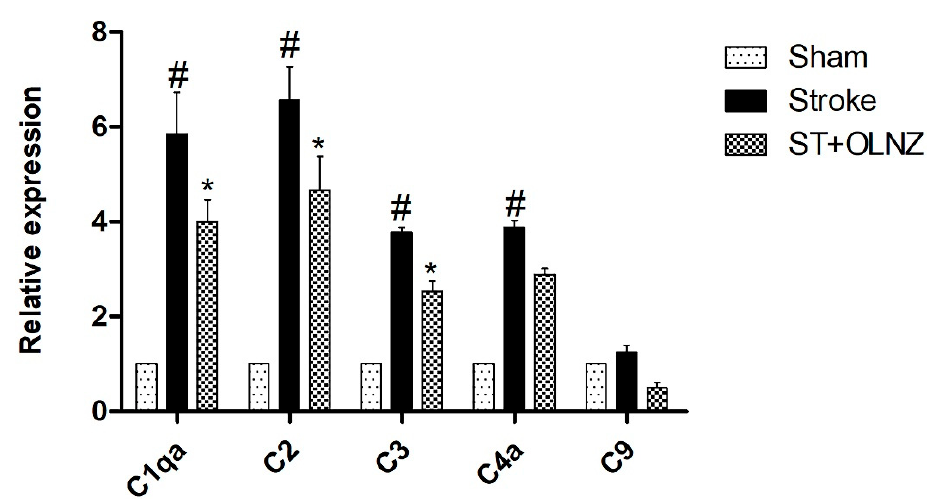
Figure 9. Protective role of OLNZ on gene expression of complement components in the hippocampus during transient-ischemia (TI)-induced stroke in gerbils. In TI-induced stroke, gene expression of C1q, C2, C3, C4a, and C9, was significantly upregulated, whereas treatment with OLNZ markedly downregulated the expression of these genes. Data were expressed as the mean ± SEM, n = 3 in each group. After performing a one-way ANOVA with Tukey’s post hoc test, p < 0.05 for comparisons of treatment groups with the sham group (#) and p < 0.05 for comparisons with the stroke group (*) were considered significant.